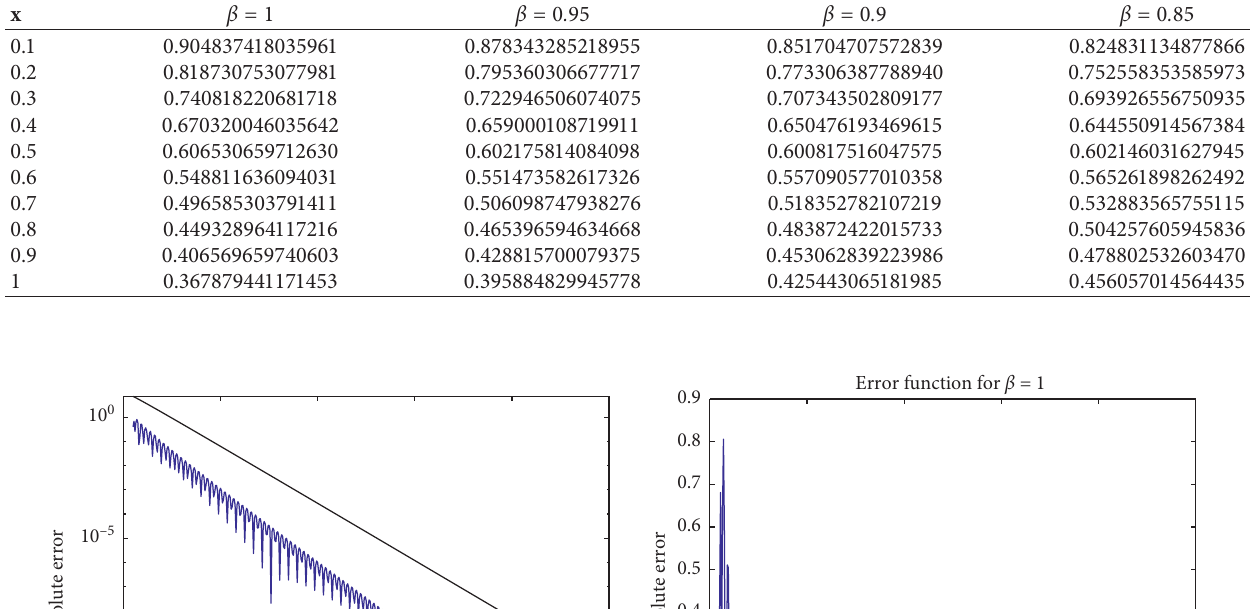
Table 6: The results are obtained for different fractional orders and N � 250.